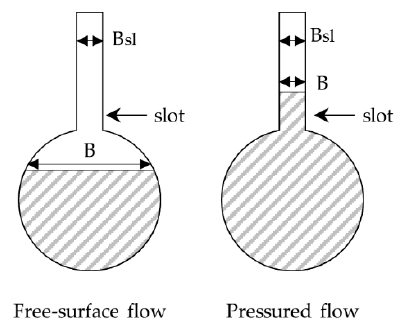
Figure 2. The Preissmann slot method.